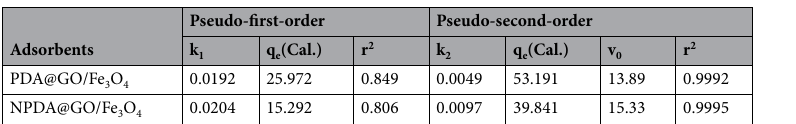
Table 2. Kinetic parameters of the pseudo-first-order and pseudo-second-order equations for the adsorption of SAR on the PDA@GO/Fe where q e and q t were the amount (mg/g) of SAR on the nanoparticles at equilibrium and t (min), respectively, k 1 (min − 1 ) and k 2 (mg·g − 1 ·min − 1 ) were the pseudo first and pseudo second order rate constants, respectively, and v 0 was the initial